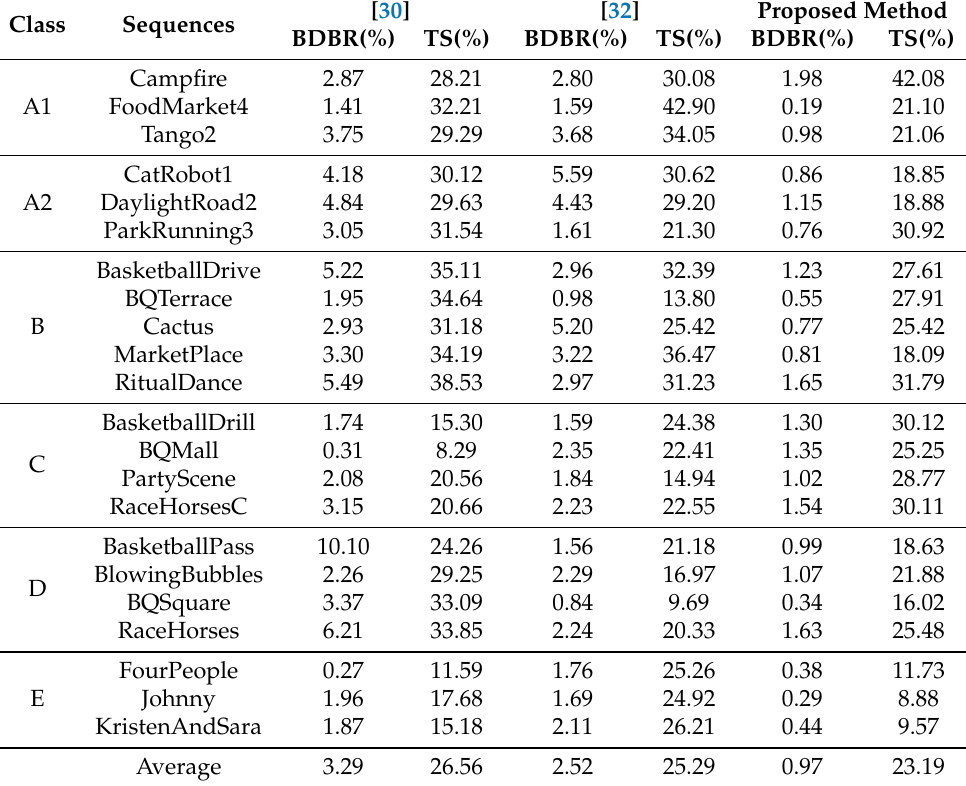
Table 8. Coding performance comparison of fast inter CU partition